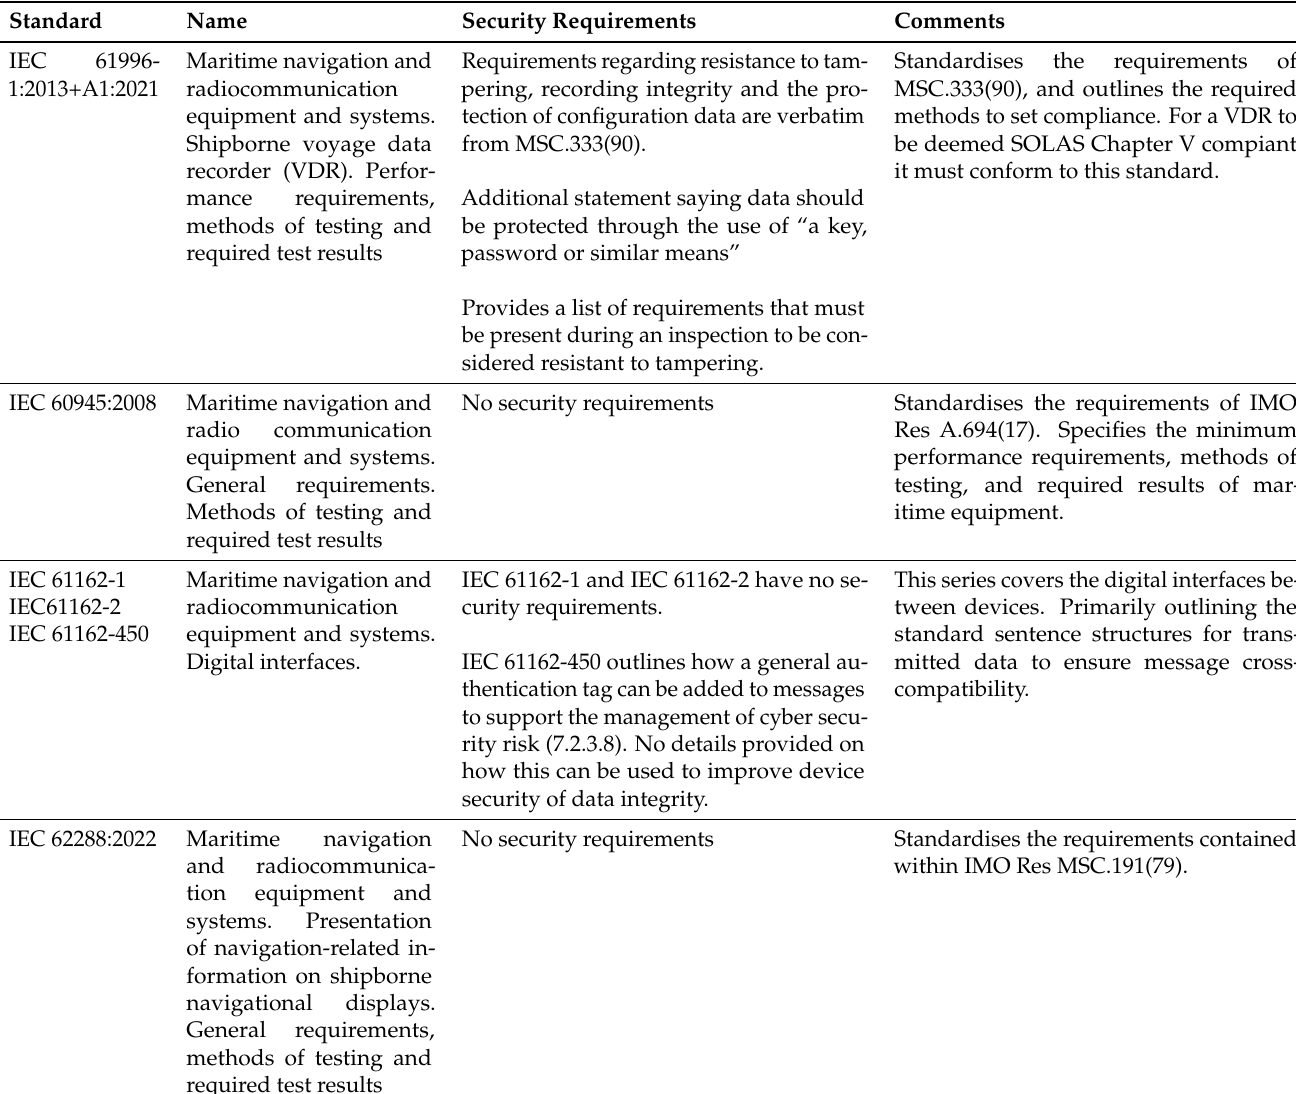
Table 3. Summary of IEC Standards Requirements for VDRs